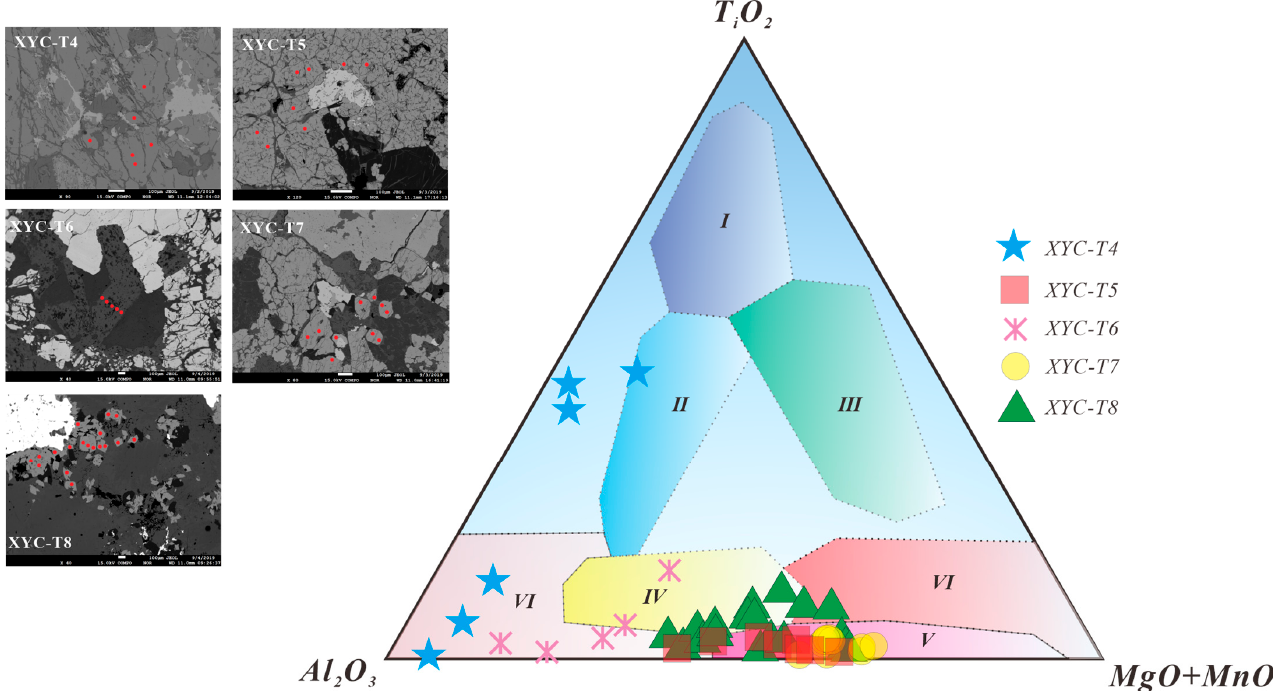
Figure 13. Genetic classification diagram of magnetite of the Xiaoyangchong deposit in the FVB (on the basis of [167]) (modified from [81]). Data sources (see Supplement Table S5): Ⅰ —accessory mineral type; Ⅱ —magma-type; Ⅲ —volcanic-type; Ⅳ —contact metasomatic-type. Ⅴ —skarn-type; Ⅵ — sedimentary metamorphic-type.